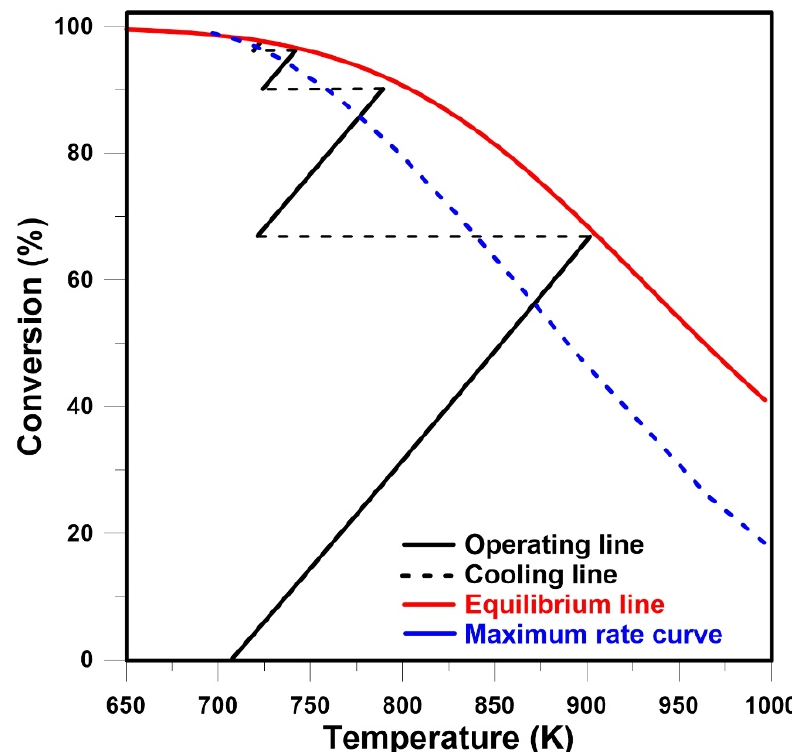
Figure 2. Typical conversion versus temperature diagram of a four catalytic bed process used to conduct the SO 2 to SO 3 reaction with gas cooling between catalytic beds. The equilibrium and maximum rate curves are shown in red and blue, respectively.